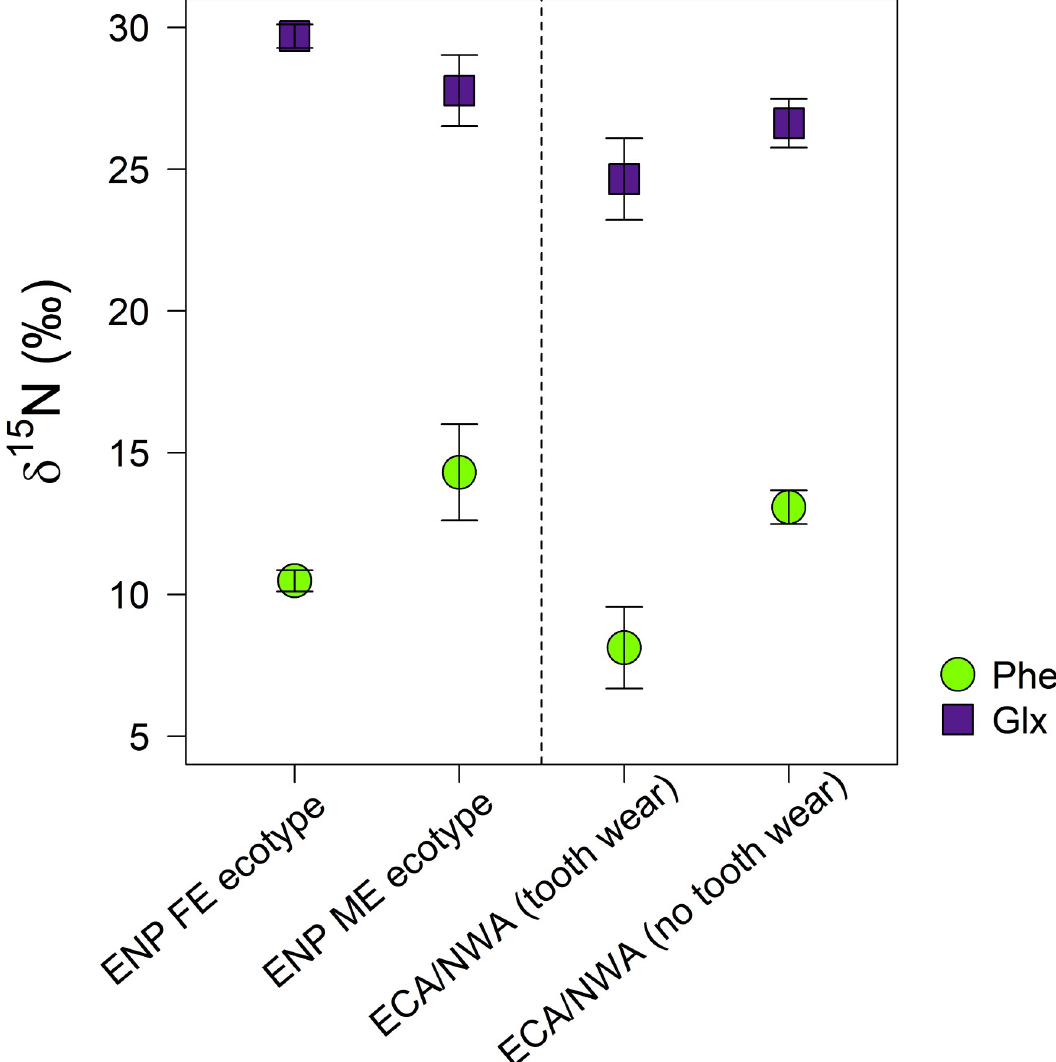
Fig 2. δ 15 N Phe (circles) and δ 15 N Glx (squares) of eastern North Pacific (ENP) killer whale ecotypes (fish-eating residents and mammal-eating transients) and eastern Canadian Arctic/Northwest Atlantic (ECA/NWA) killer whales with tooth wear and no tooth wear (error bars = standard deviation). Similar relative differences in δ 15 N Glx-Phe among the ECA/NWA groups as the ENP ecotypes suggest similar dietary